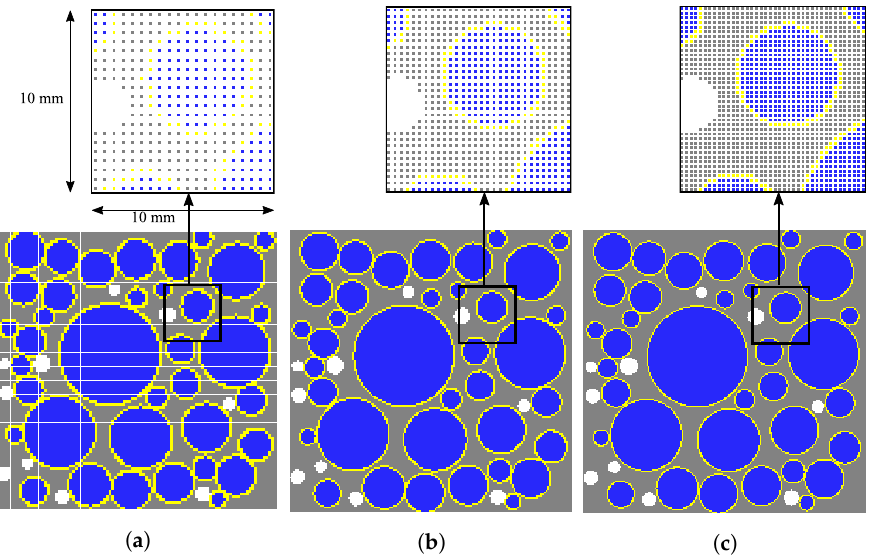
Figure 5. Numerical specimens with varying particle spacing, h . ( a ) h = 1/2 mm; ( b ) h = 1/3 mm; ( c ) h = 1/4 mm.